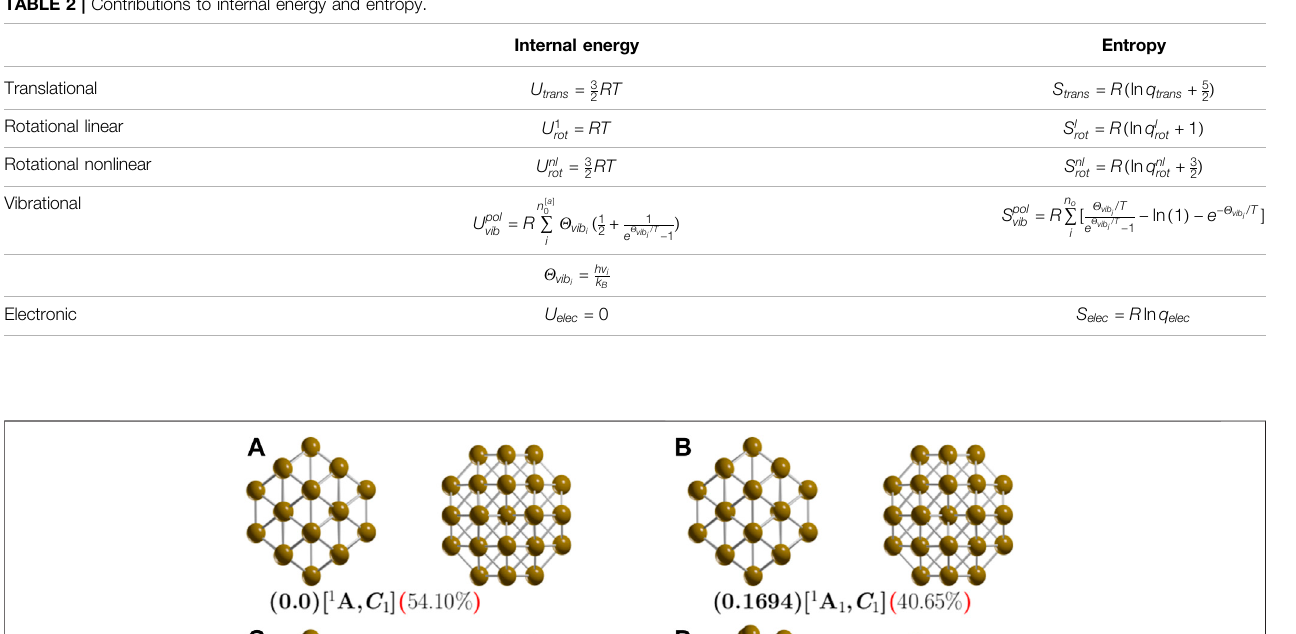
Frontiers in Chemistry |